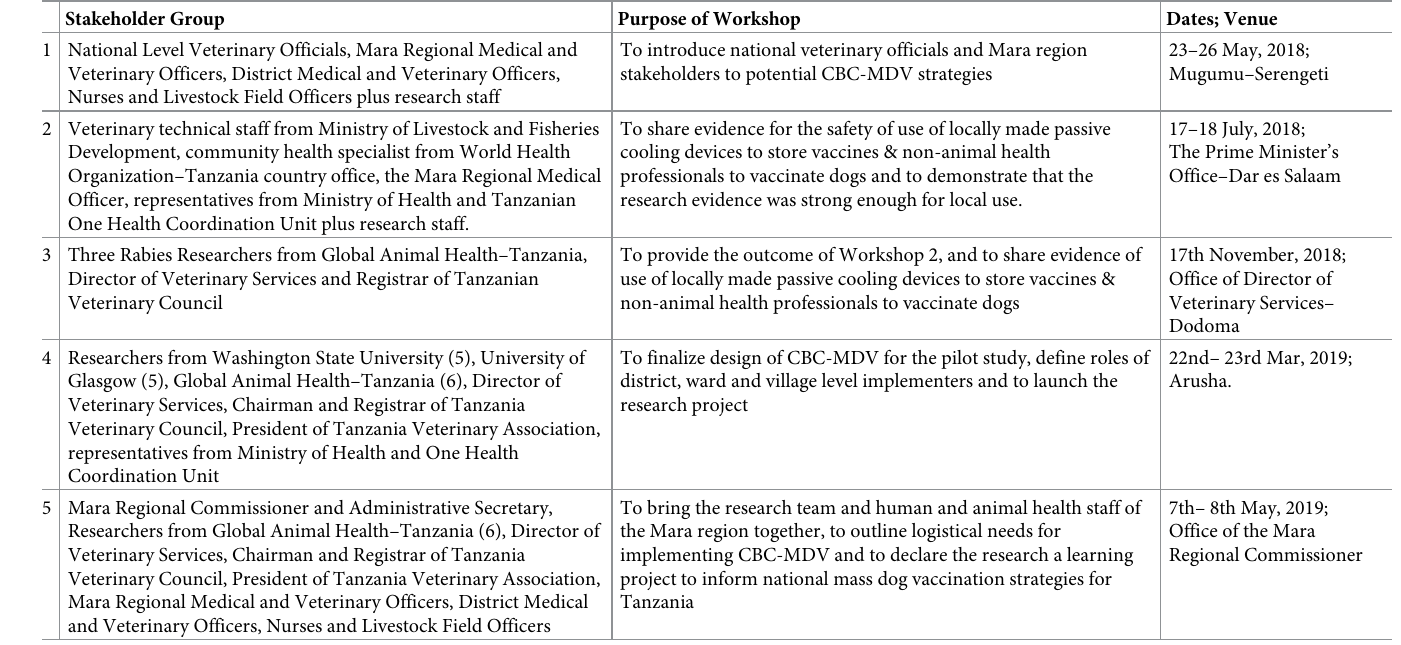
Table 1. Stakeholder group, purpose and date of engagement workshops.